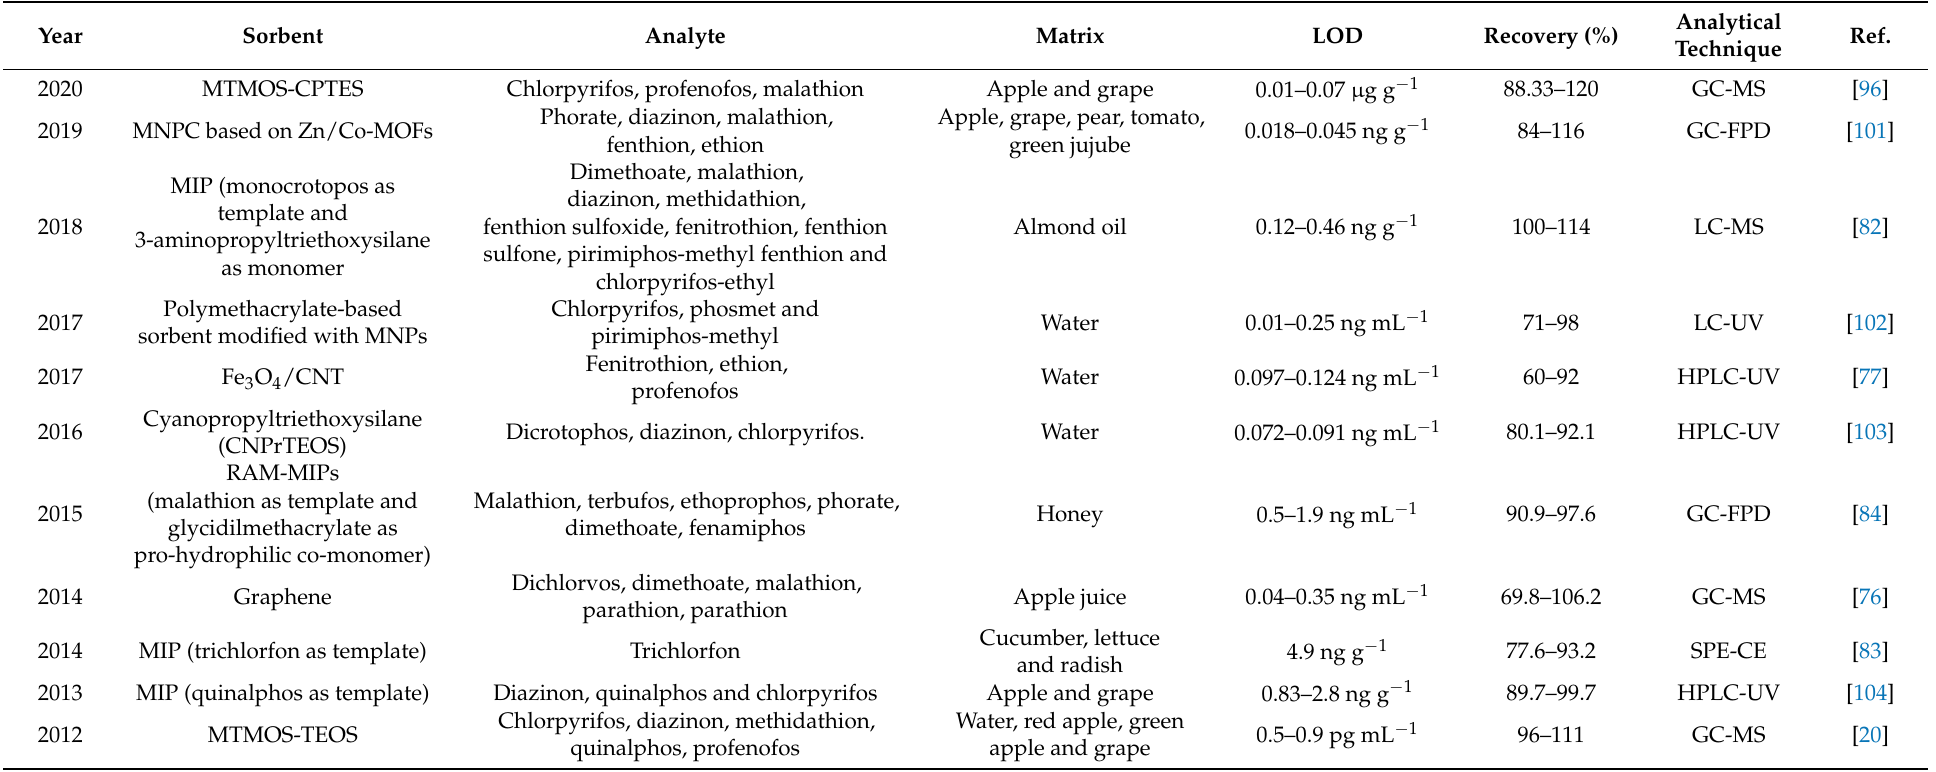
Table 7. Summary of past studies on the application of SPE as a sample preparation technique for OPPs’